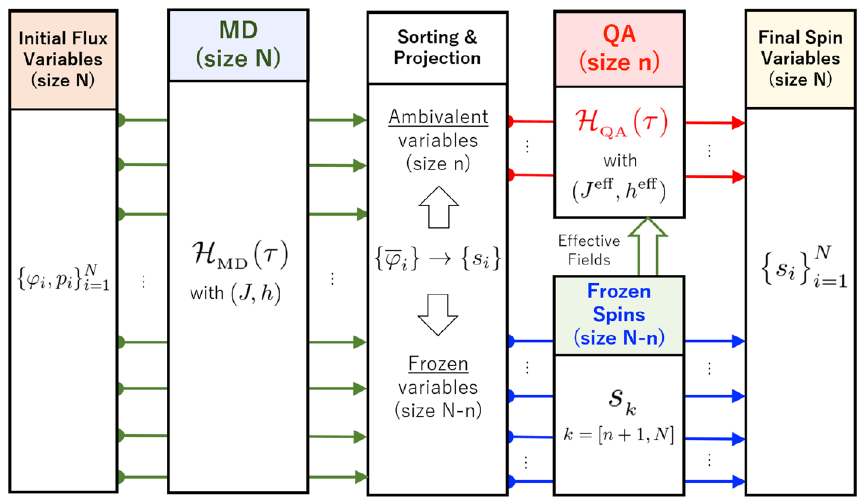
Figure 5. Flowchart of the hybrid quantum annealing (HQA) via molecular dynamics (MD).